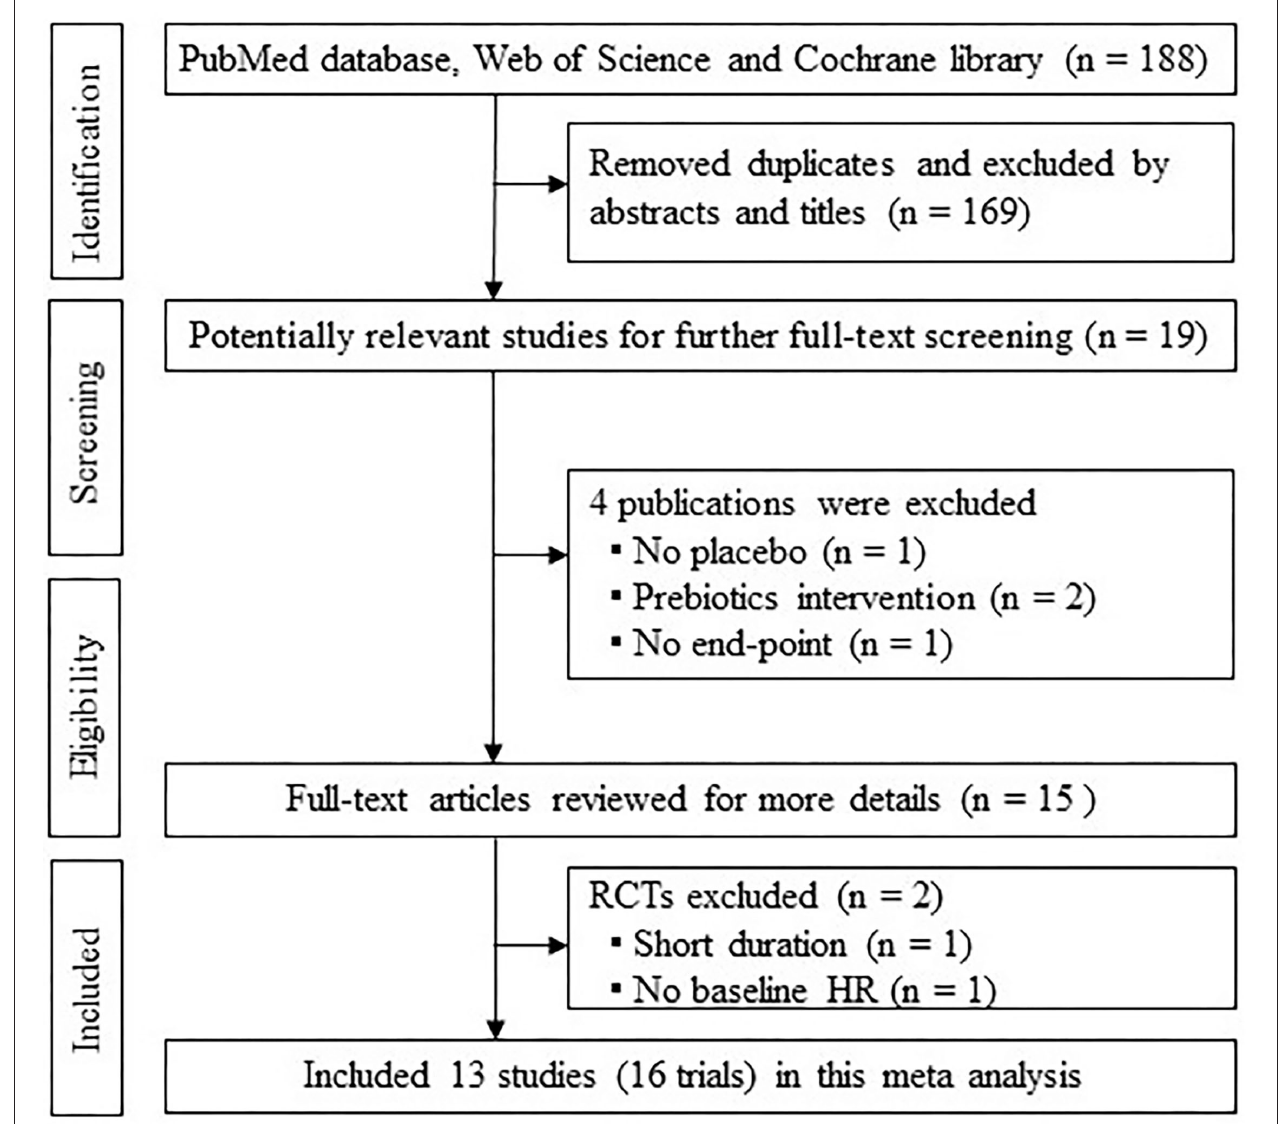
FIGURE 1 | Flow chart of literature selection